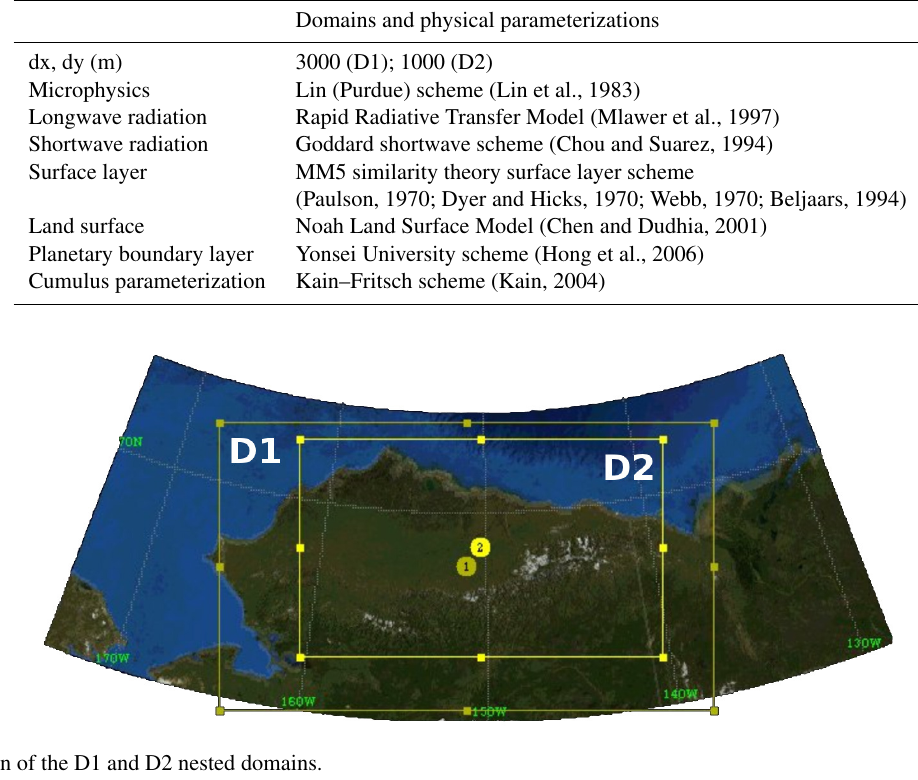
Figure 2. Location of the D1 and D2 nested